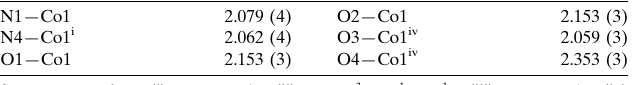
Key indicators: single-crystal X-ray study; T = 291 K; mean (cid:2) (C–C) = 0.006 A˚; disorder in solvent or counterion; R factor = 0.057; wR factor = 0.134; data-to- parameter ratio = 16.4.